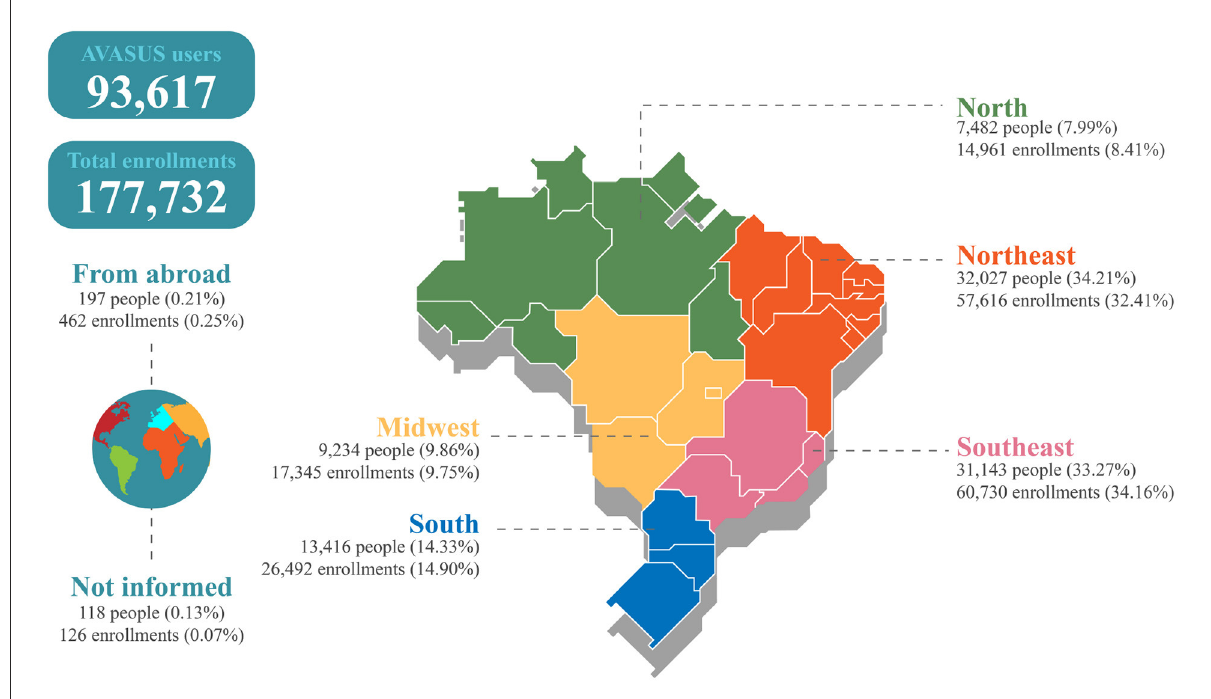
FIGURE4 Geographical distribution of participants and enrollments in the learning pathway “Syphilis and other